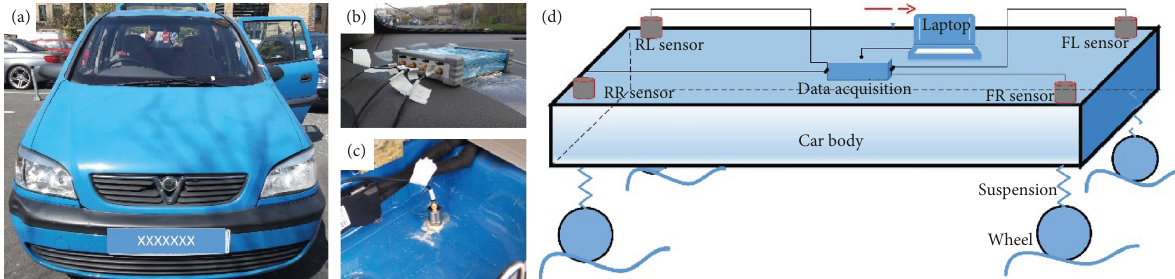
Figure 13: (a) Test car; (b) data acquisition equipment; (c) accelerometer; (d) schematic of test system.